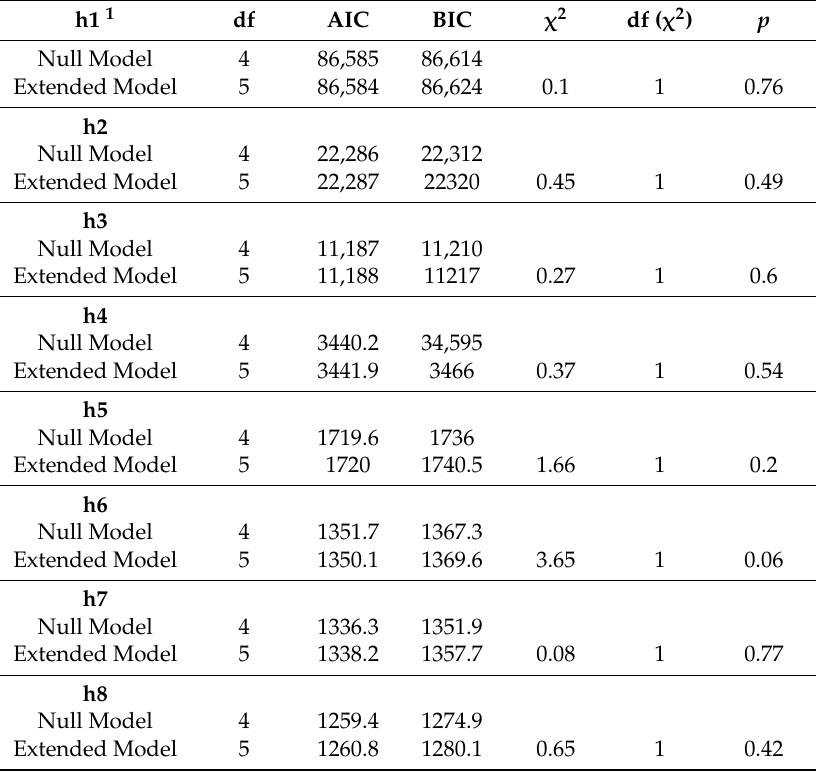
Table A3. Likelihood ratio tests for the null and extended models applied to free parameters in transition matrix H .